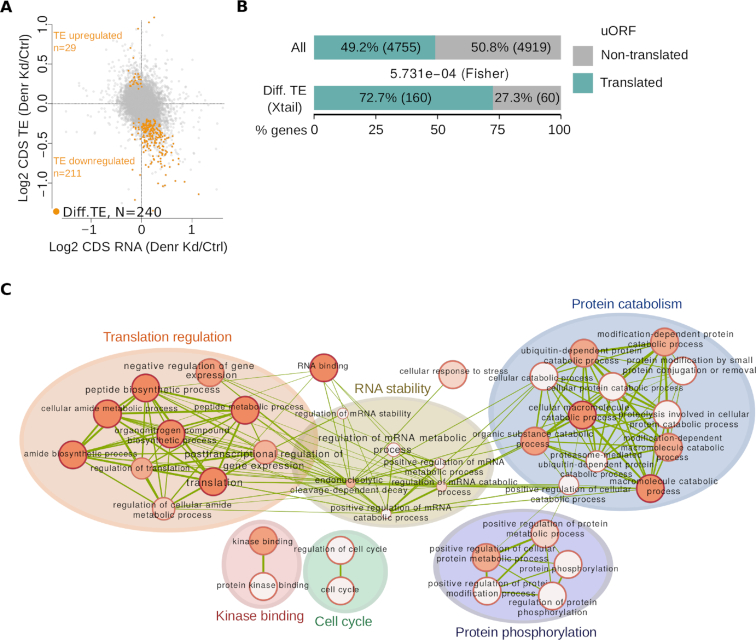
Characteristics of DENR targets: decreased CDS TE; enrichment for uORFs; association with functional categories. (A) Scatter plot of Denr Kd-to-control ratio of mRNA abundance versus CDS translation efficiency (TE) for all expressed genes (N = 10 516). Highlighted in orange are genes with differential TE (detected by Xtail (22), FDR < 0.1, N = 240), the majority of which showed decreased TE in Denr Kd cells, in line with a role of DENR in regulating translation reinitiation. (B) uORF enrichment in DENR targets. Proportion of genes with translated uORFs transcriptome-wide compared to that among the differential TE genes detected in panel (A). DENR targets showed enrichment for translated uORF-containing genes (P = 5.73e-4, Fisher test). (C) Enrichment map for GO-Biological process, GO-Metabolic function and Reactome functional categories of genes with differential TE. Only categories with an FDR < 0.05 in the GO analysis were considered. Node size is proportional to the number of genes associated with the GO category, shading corresponds to the statistical significance, and edge width is proportional to the number of genes shared between functional categories.